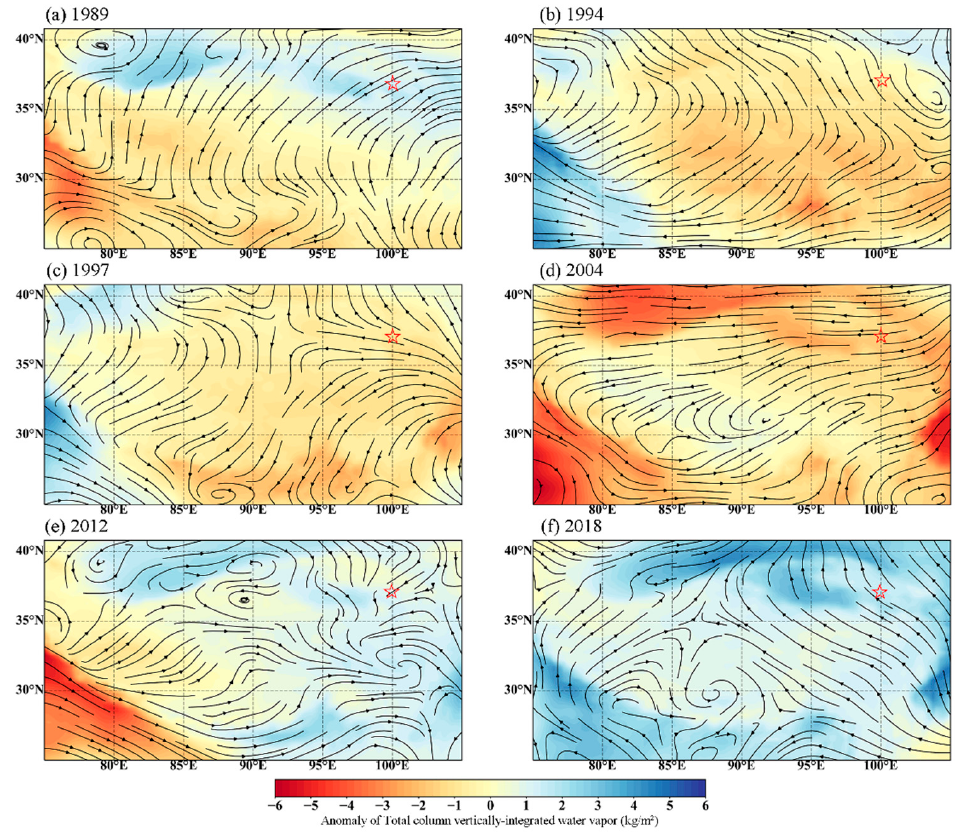
Figure 10. Anomaly distribution of vertically integrated summer water vapor in ( a ) 1989, ( b ) 1994, ( c ) 1997, ( d ) 2004, ( e ) 2012, and ( f ) 2018. The arrows represented water vapor transport. The red star showed the location of the QHL.